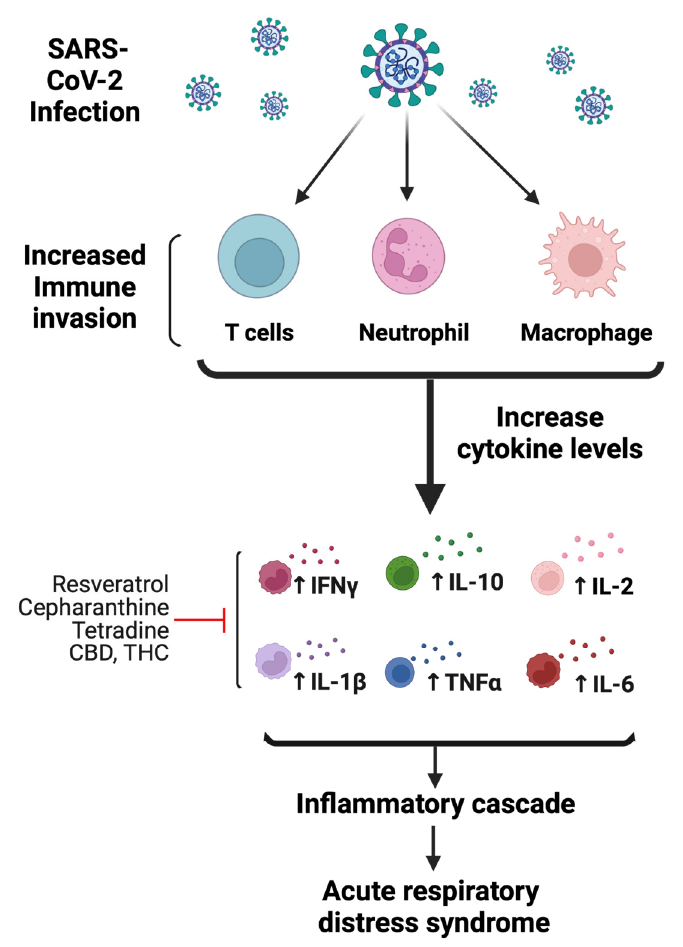
Figure 4. Mechanisms of SARS-CoV-2-mediated immunomodulatory and inflammatory response. Following infection, SARS-CoV-2 hyperactivates immune cells, such as T cells, macrophages, and neutrophils. Initial increase in immune response activates proinflammatory cytokines. As a result, cytokine levels increase, which include IL-2, IL-6, IL-7, IL-10, IFN- γ , and TNF α . The increase in immune response leading to increased cytokine levels is associated with lung pathology likely causing acute respiratory distress syndrome. Red line indicates the possible anti-inflammatory mechanism of bioactive compounds (figure created with Biorender.com).